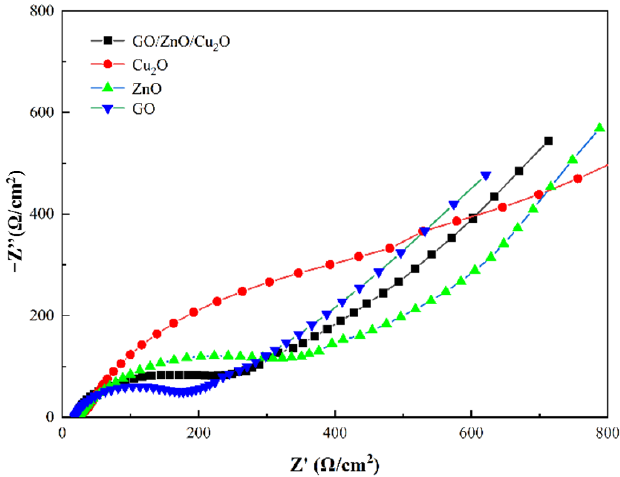
Figure 10. Photocurrent response spectra of GO, ZnO, Cu 2 O and GZC antibacterial powder.